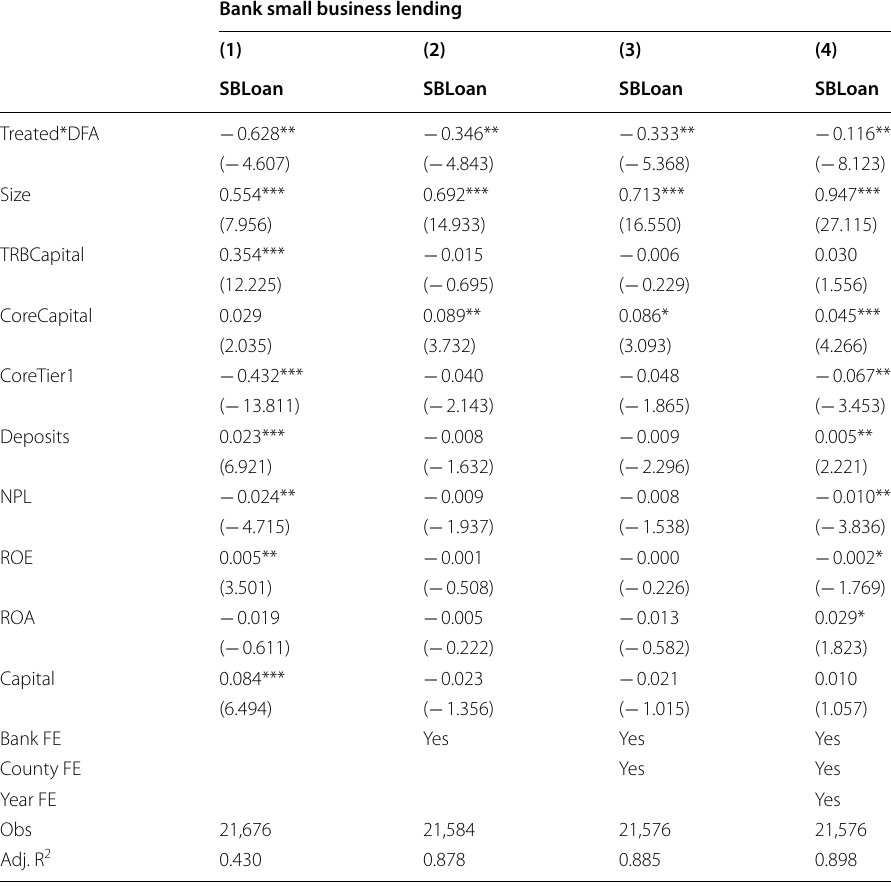
Table 5 Impact of Dodd-Frank Act on bank small business credit